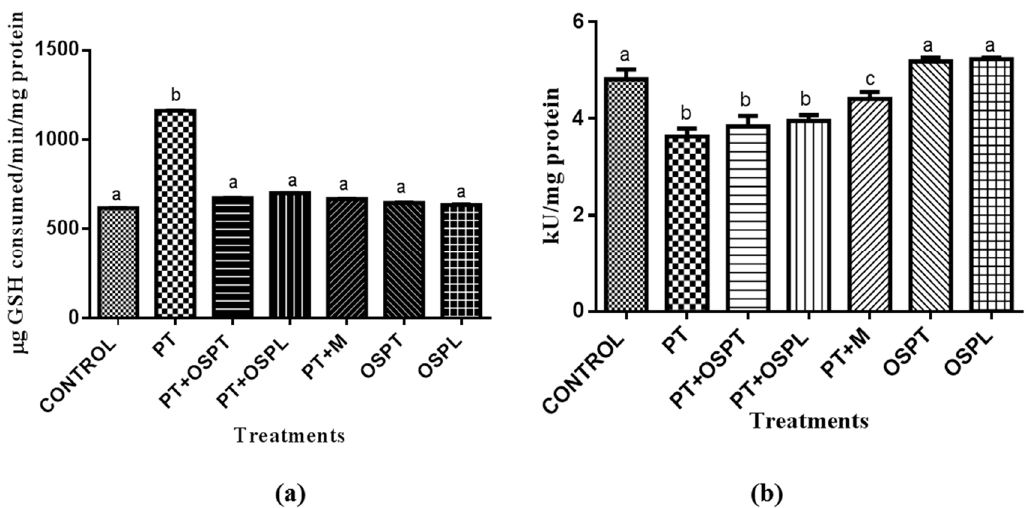
Figure 3. The effect of orange fleshed sweet potato extracts on ( a ) glutathione peroxidase (GPx) activity and ( b ) Catalase (CAT) activity in treated C2C12 myotubes. Treatment groups were palmitate (PT), palmitate and tubers’ extract of orange fleshed sweet potato (PT + OSPT), palmitate and leaves’ extract of orange fleshed sweet potato (PT + OSPL), palmitate and metformin (PT + M), tubers’ extract of orange fleshed sweet potato only (OSPT), leaves’ extract of orange fleshed sweet potato only (OSPL). Different letters denote statistical significant differences between results ( p < 0.05). Bars indicate standard deviation ( n = 3).